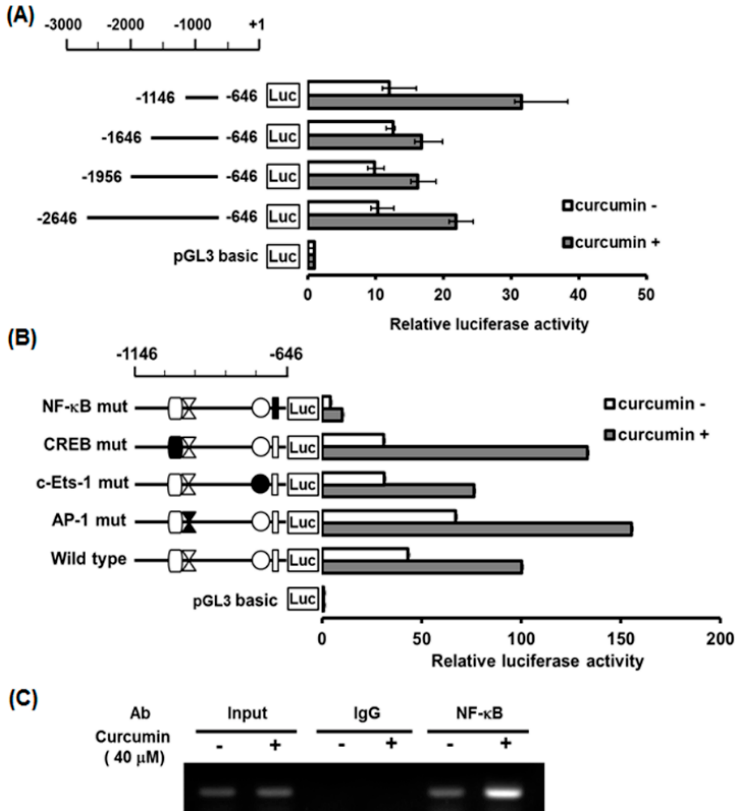
Figure 5. Effect of curcumin on hST8Sia I promoter activity in A549 cells. The schematic diagrams represent DNA constructs ( A ) containing 5 ′ -deletion of the wild-type hST8Sia I promoter, or constructs ( B ) with mutants c-Ets-1, AP-1, CREB, and NF- κ B sites located at the -1146 to -646 region; the start codon is designated as +1. The promoterless pGL3-basic construct was used as a negative control. Each construct and pRL-TK as an internal control were co-transfected into A549 cells. Transfected cells were cultivated in the presence (solid bar) or absence (open bar) of 40 μ M curcumin for 24 h. Relative firefly luciferase activity was measured using the Dual-Luciferase Reporter Assay System, and all firefly activity was normalized to the Renilla luciferase activity derived from pRL-TK. ( C ) PCR amplification in the -1146 and -646 regions of the hST8Sia I promoter on immunoprecipitated chromatin obtained from A549 cells treated with or without curcumin. The input (10-fold diluted) represents the positive control. hST8Sia I mRNA was detected by RT-PCR. β -Actin was utilized as an internal control.